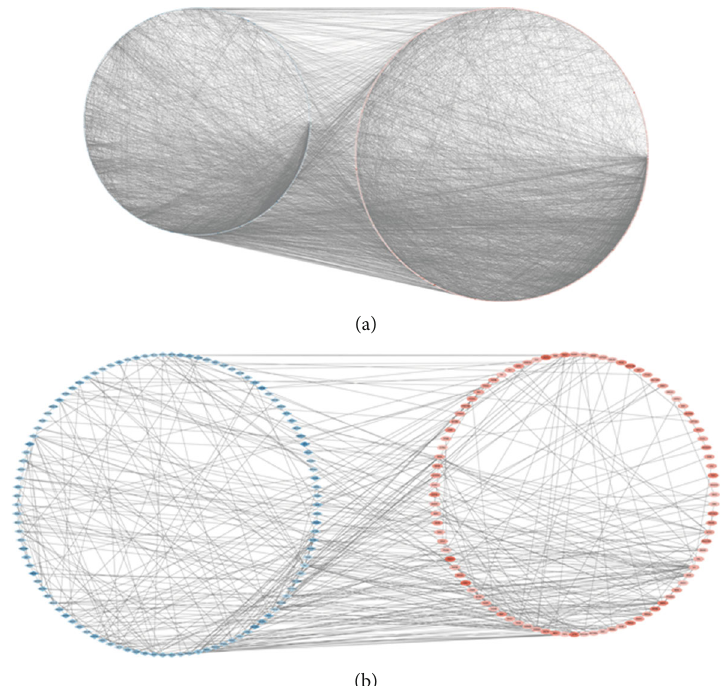
Figure 4: All DEG PPI networks are visualized via Cytoscape. Red balls represent upregulated genes, and blue diamonds represent downregulated genes. (a) RA and No-RA groups. (b) M-RA and F-RA